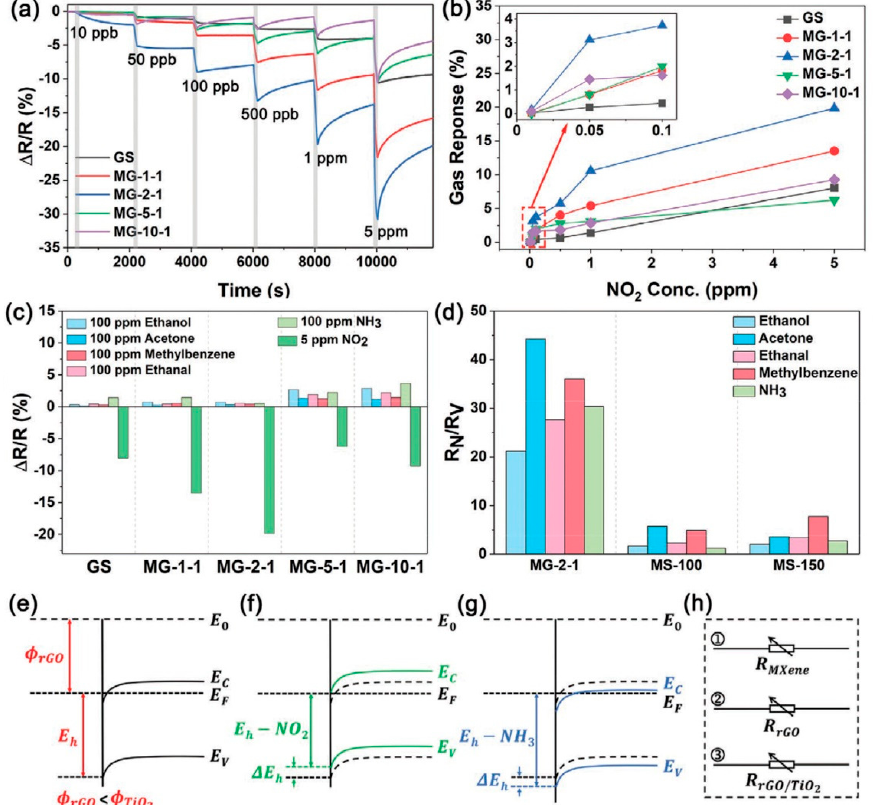
Figure 10. ( a ) The dynamic response/recovery curve of sensors based on GS, MG-1-1, MG-2-1, MG-5-1, and MG-10-1 in the different concentrations of dry NO 2 . ( b ) The gas response curve of sensors based on GS, MG-1-1, MG-2-1, MG-5-1, and MG-10-1 depending on dry NO 2 concentration. ( c ) The maximum resistance change rate of sensors based on GS, MG-1-1, MG-2-1, MG-5-1, and MG-10-1 to 100 ppm of dry ethanol, acetone, ethanal, methylbenzene, NH 3 , and 5 ppm of dry NO 2 within two minutes of exposure. ( d ) The response ratio (R N / R V ×100%) of sensors based on MG-2-1, MS-100, and MS-150 to 5 ppm dry NO 2 (R N ) relative to various 100 ppm other dry gases (R V ). ( e ) The schematic illustration of energy band of rGO/TiO 2 contact. The change of energy band of rGO/TiO 2 heterojunction after exposure to ( f ) NO 2 and ( g ) NH 3 . ( h ) A schematic illustration of the mechanism of gas-sensing response of MGs. Reprinted with permission from [104]. Copyright 2021: Wiley-VCH GmbH.